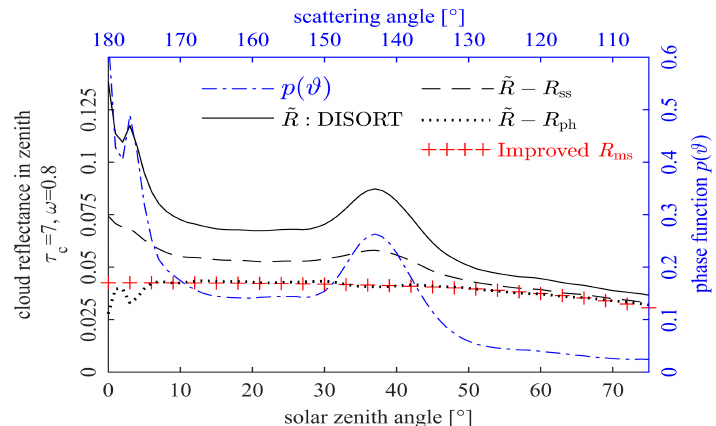
Figure 3. Cloud reflectance and its components. Dashed line: the reflection after removing the single-scattering part. Dotted line: similar to the dashed line, but further removes the contribution of forward-scattering.